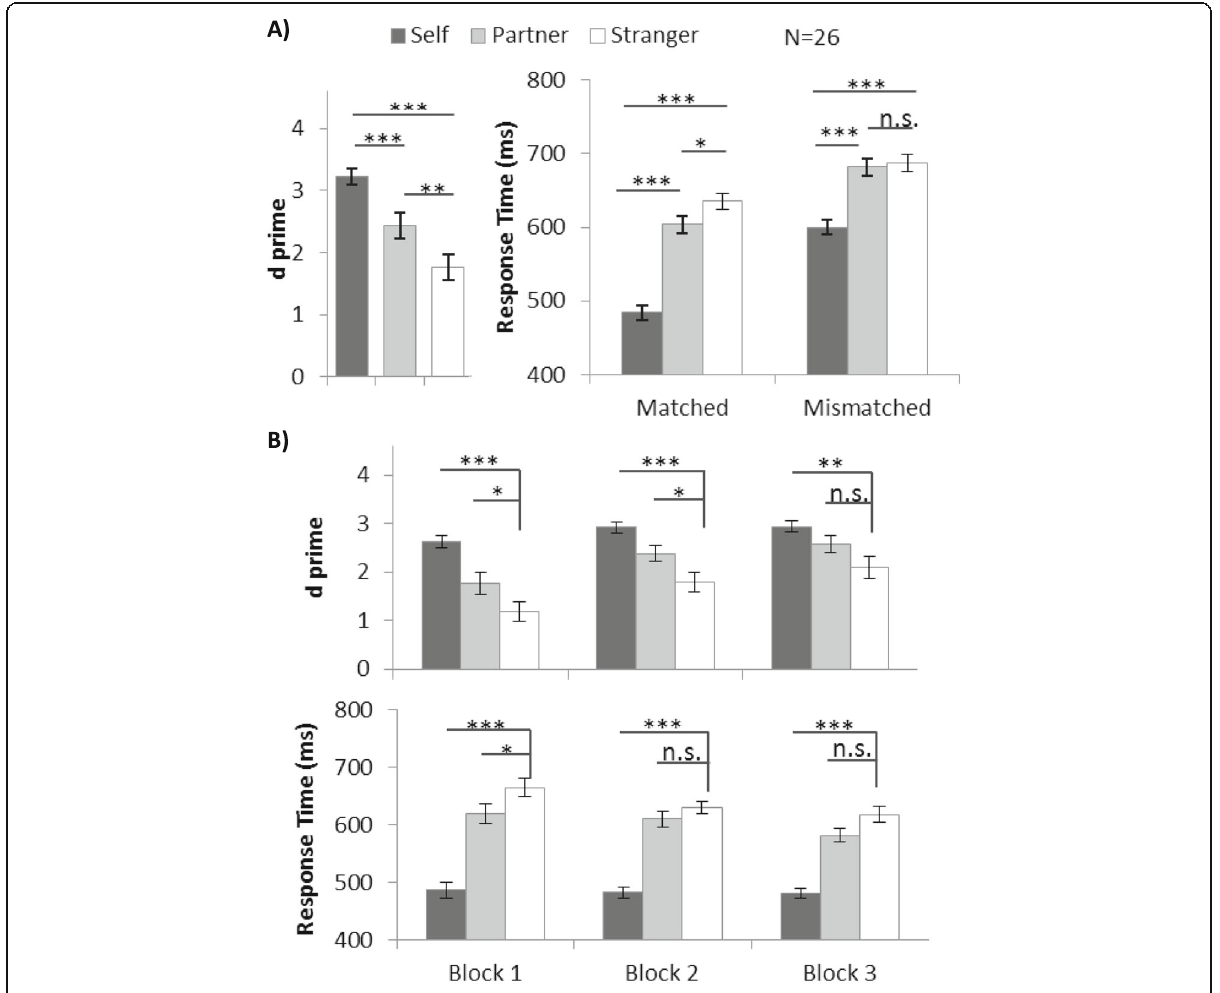
Fig. 3 a Mean and SE of d prime ( d ’ ) for different shape categories in experiment 2. b Mean and SE of d ’ and response time (RT) (matched trials) for different shape categories for each block in experiment 2 (* p < .05, ** p < .01, *** p < .001). n.s., not